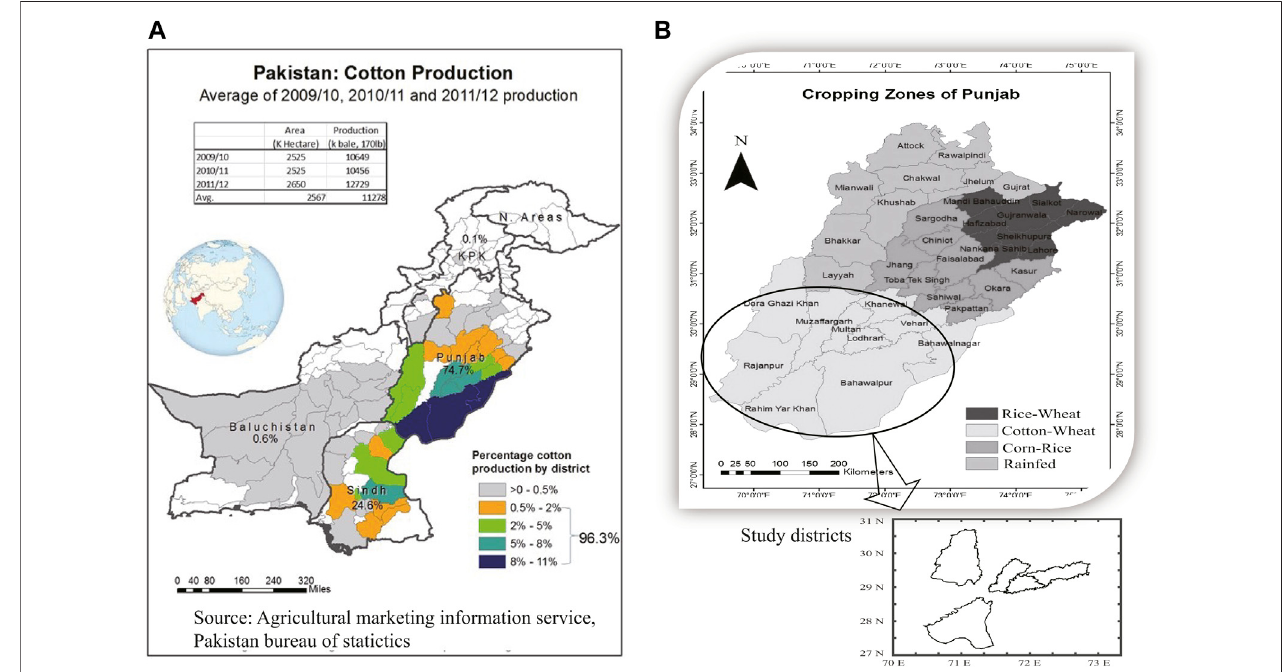
FIGURE 1 | (A) The selected area for good execution of this study which clearly indicates the high density of cotton growers, strongly concentrated in speci fi c regions only (districts). (B) The geographical information and percentage of cotton production in selected districts.